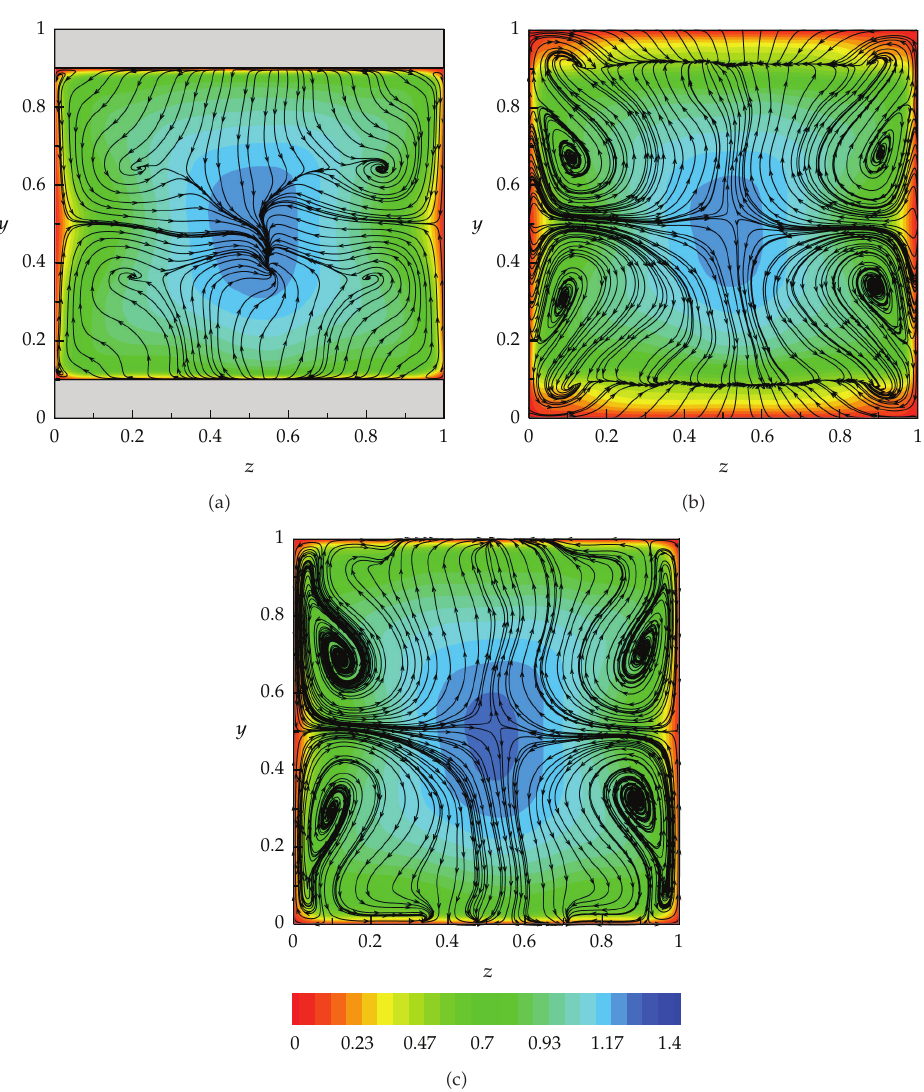
Figure 10: Time-averaged streamline superimposed on temperature contours at three streamwise locations (cid:2) a (cid:3) center of rib (cid:2) x/e (cid:8) 5 (cid:3) , (cid:2) b (cid:3) at (cid:2) x/e (cid:8) 7 . 5 (cid:3) , and (cid:2) c (cid:3) downstream of reattachment point (cid:2) x/e (cid:8) 1 . 5 (cid:3) .